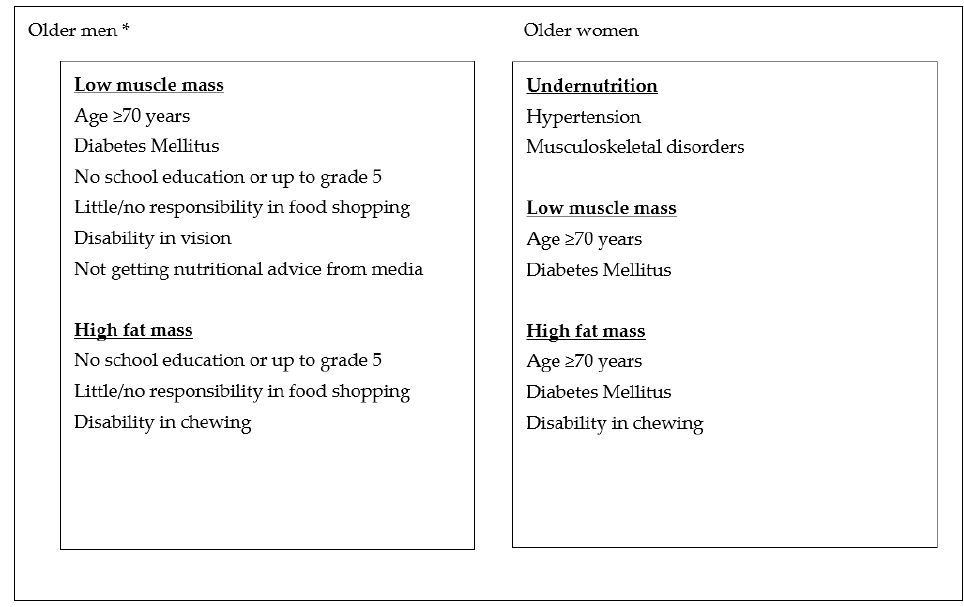
Figure 1. Summary of the factors associated with undernutrition, low muscle and high fat mass among older men and women. * Associated factors have a significant inverse association .